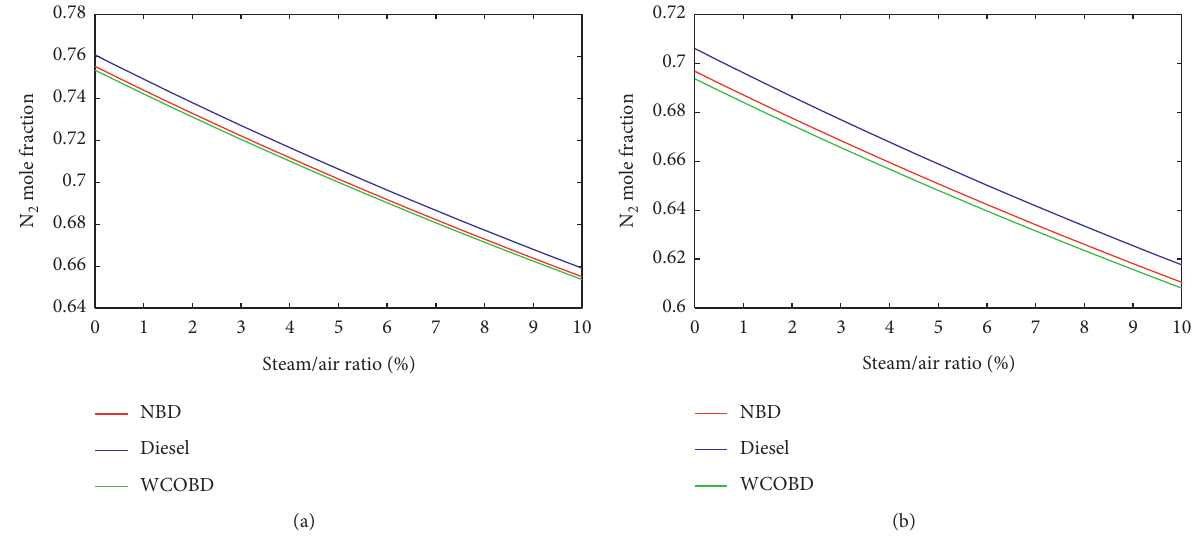
Figure 3: Variation of N 2 equilibrium mole fractions with steam injection ratios.